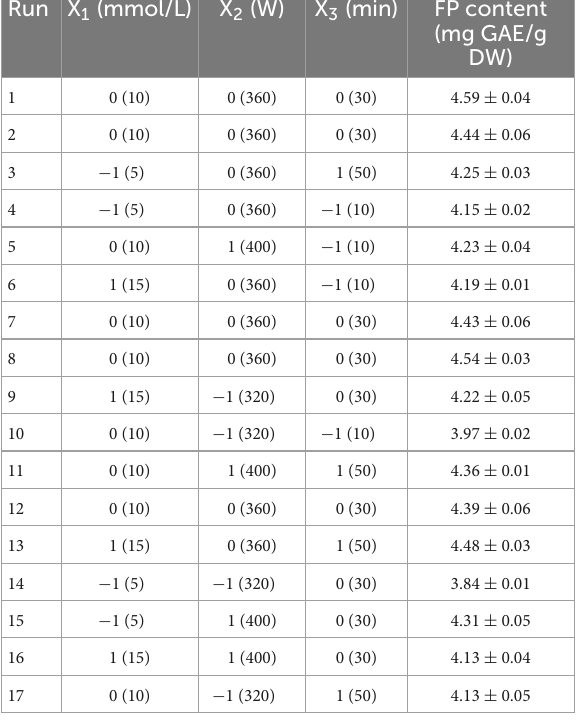
TABLE 2 Response surface design and free polyphenols content of the mung bean